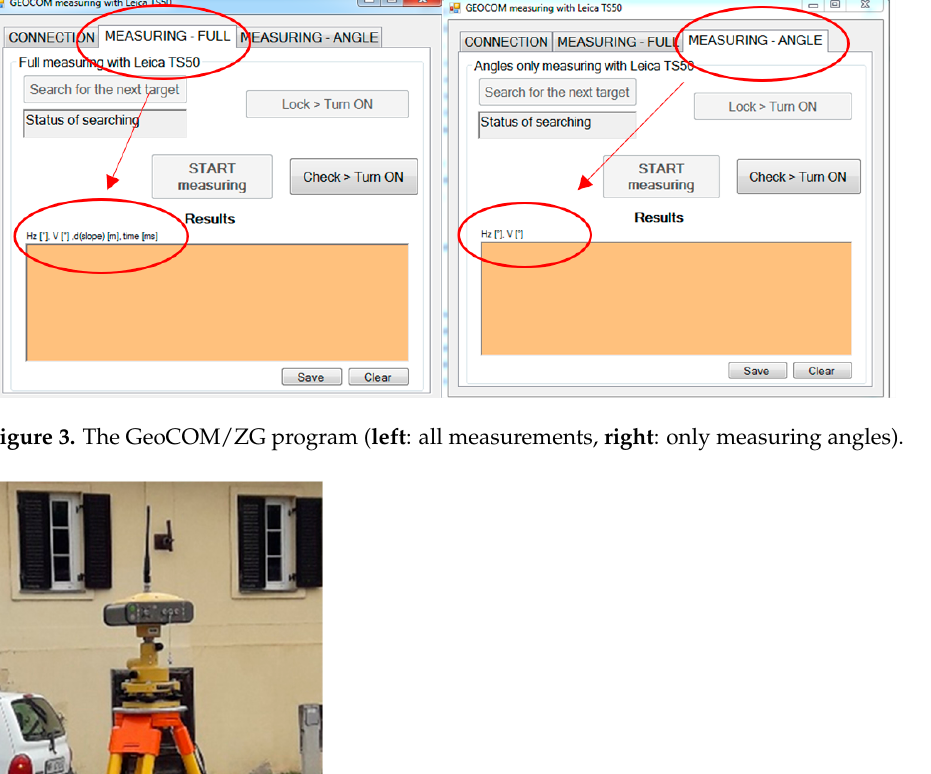
Figure 3. The GeoCOM/ZG program ( left : all measurements, right : only measuring angles).